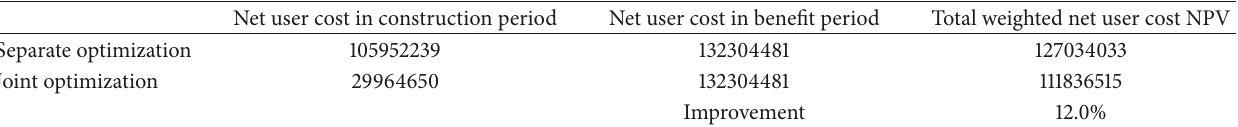
Table 4: System performance comparison for Scenario 2 .